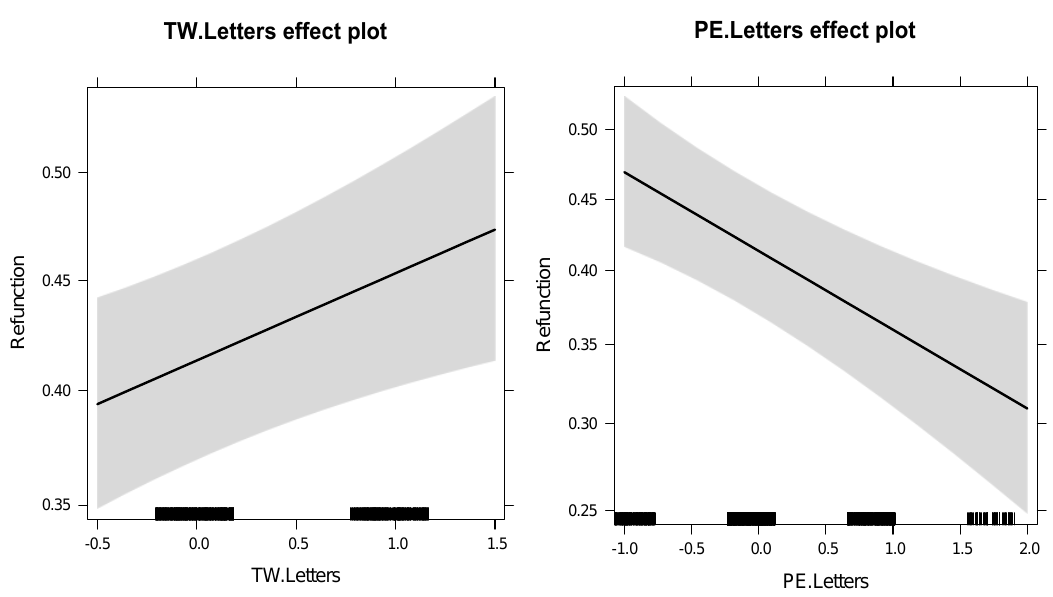
Figure 3. Effect plot for TW.L ETTERS and PE.L ETTERS .